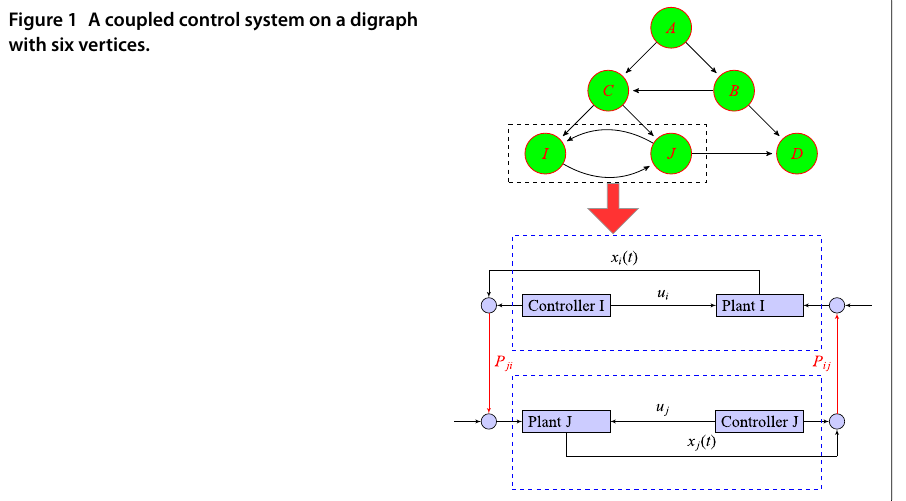
Figure 1 A coupled control system on a digraph with six